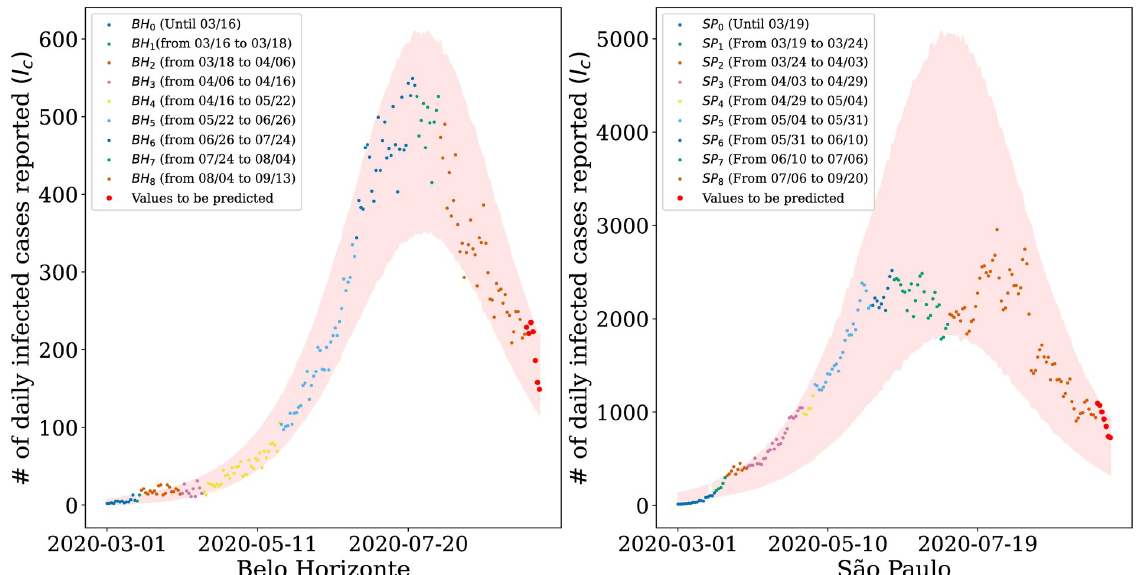
Fig 6. Simulation results for daily infected cases reported. Number of infected people estimated by our model for the cities of (a) Belo Horizonte and (b) S ã o Paulo. The shaded areas represent the 95% confidence region provided by the model and the points the official daily values